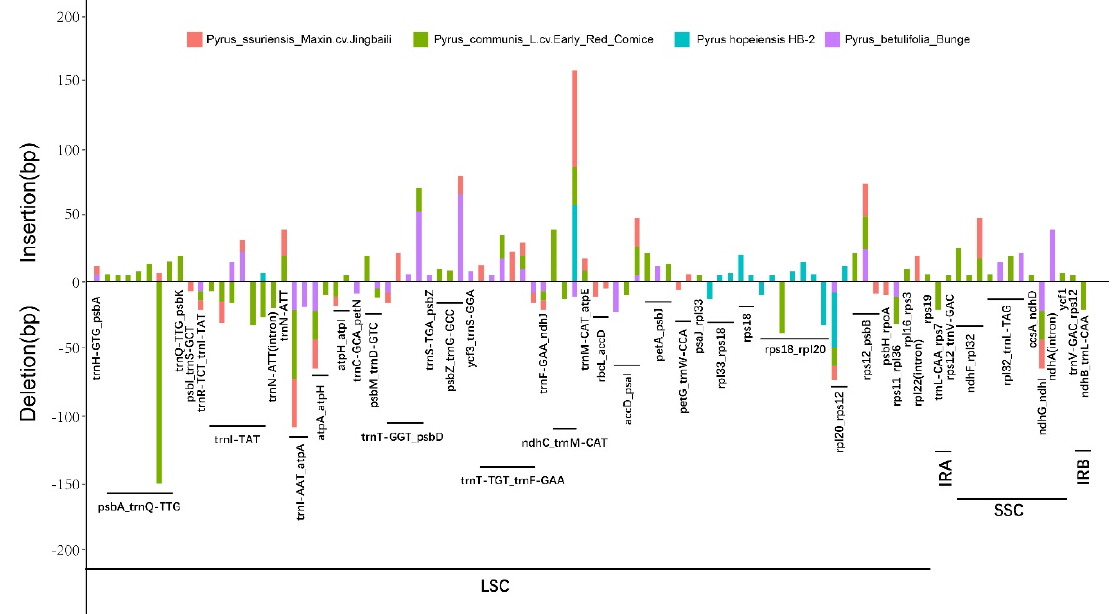
Figure 3. Indels ( ≥ 5 bp) identified based on multiple sequence alignment of five Pyrus cp genomes. Insertions are shown above and deletions below the horizontal axis. Indel distribution was positioned using Pyrus hopeiensis HB-1 as a reference.